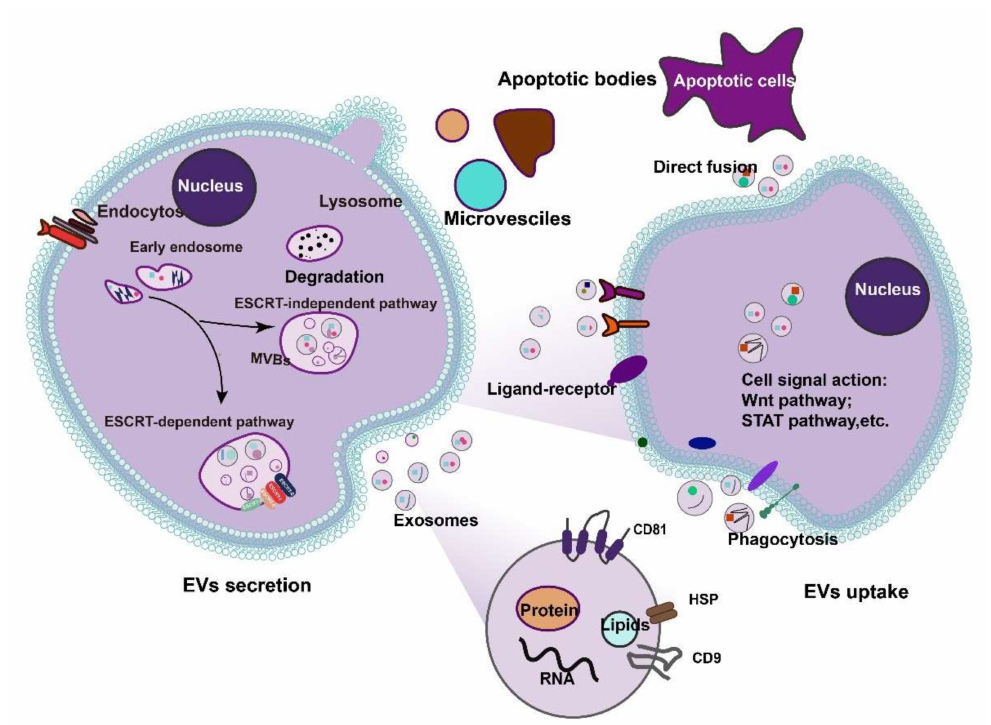
Figure 1. Secretion and uptake of extracellular vesicles (EVs). EVs are currently classified into three categories depending on their origin, secretion mechanism, and size: exosomes, microvesicles, and apoptotic bodies. EVs interact with recipient/target cells and act as messengers for signal delivery: interactions with plasma membrane receptors, phagocytosis into cells, and direct fusion with the plasma